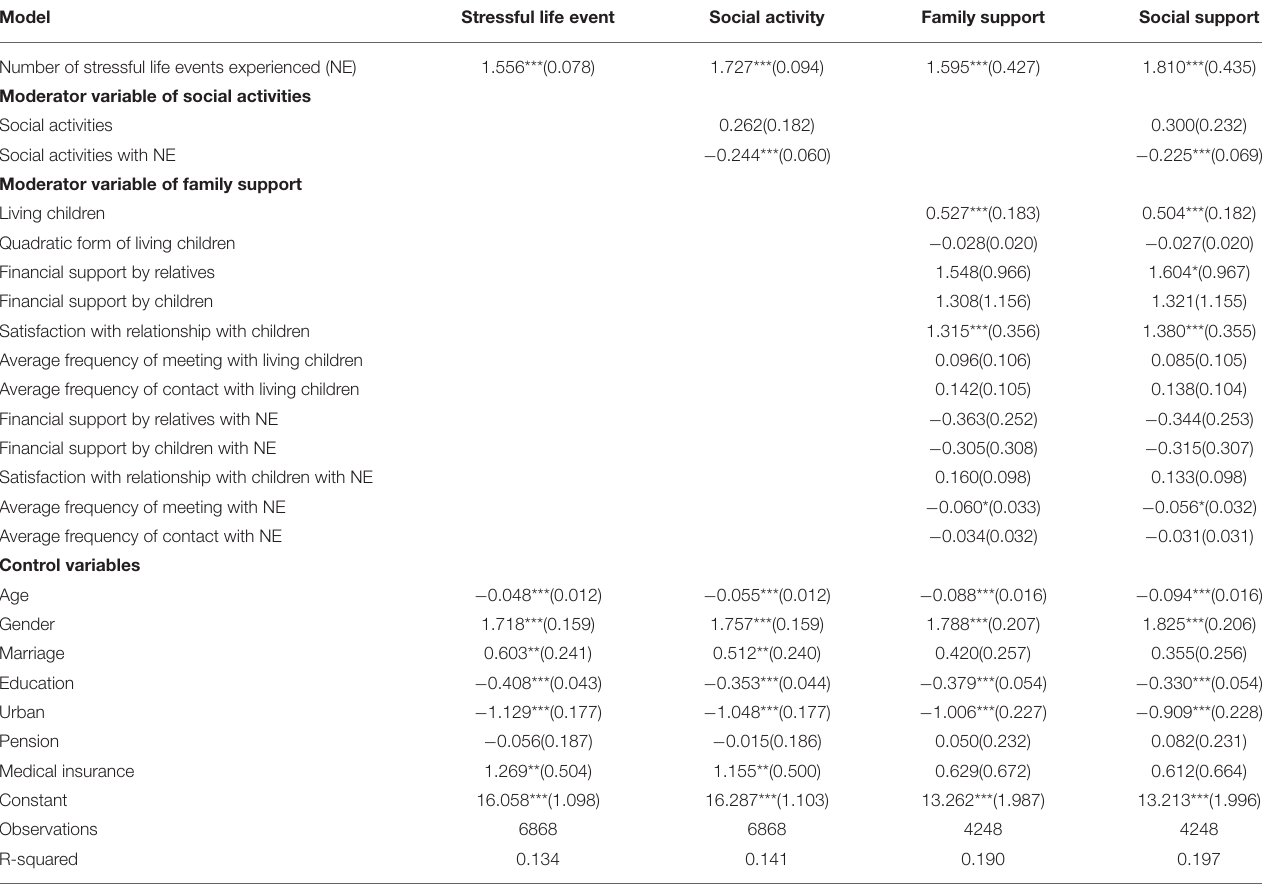
TABLE 1 | Descriptive statistics of the variables.